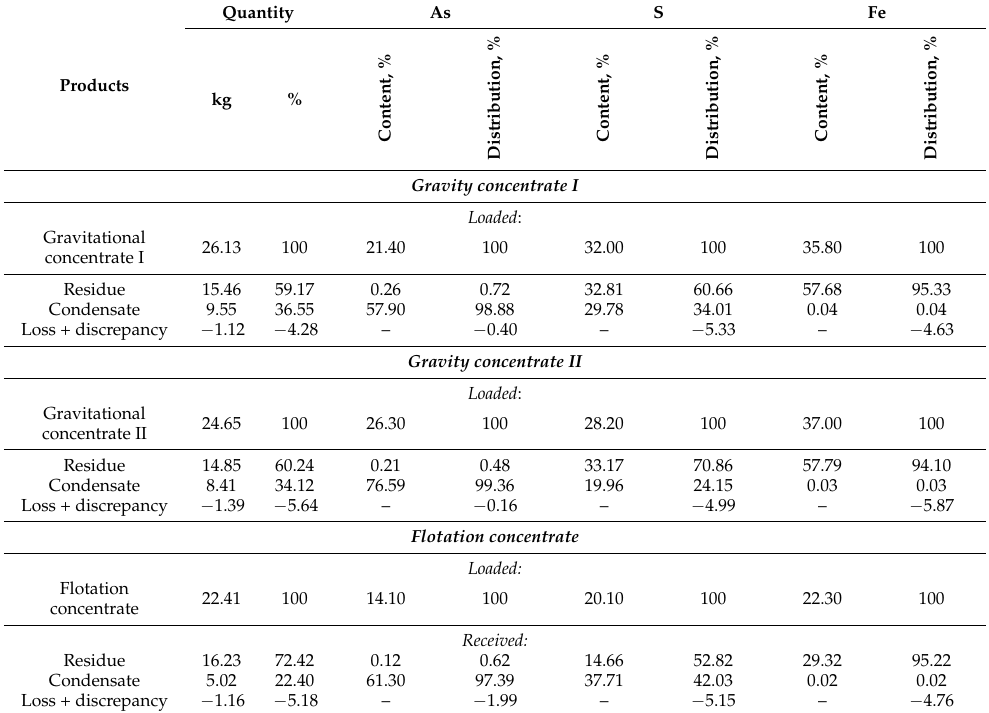
Table 3. Content and distribution of elements in products of vacuum-thermal processing of Bakyrchik concentrates.